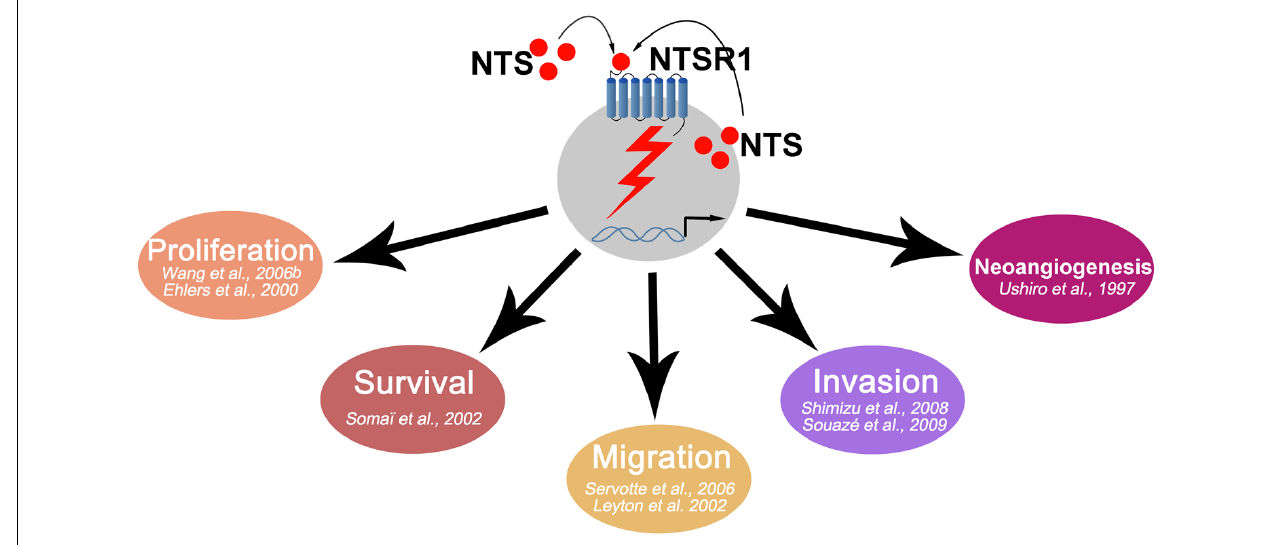
FIGURE 1 | Schematic representation of NTS oncogenic